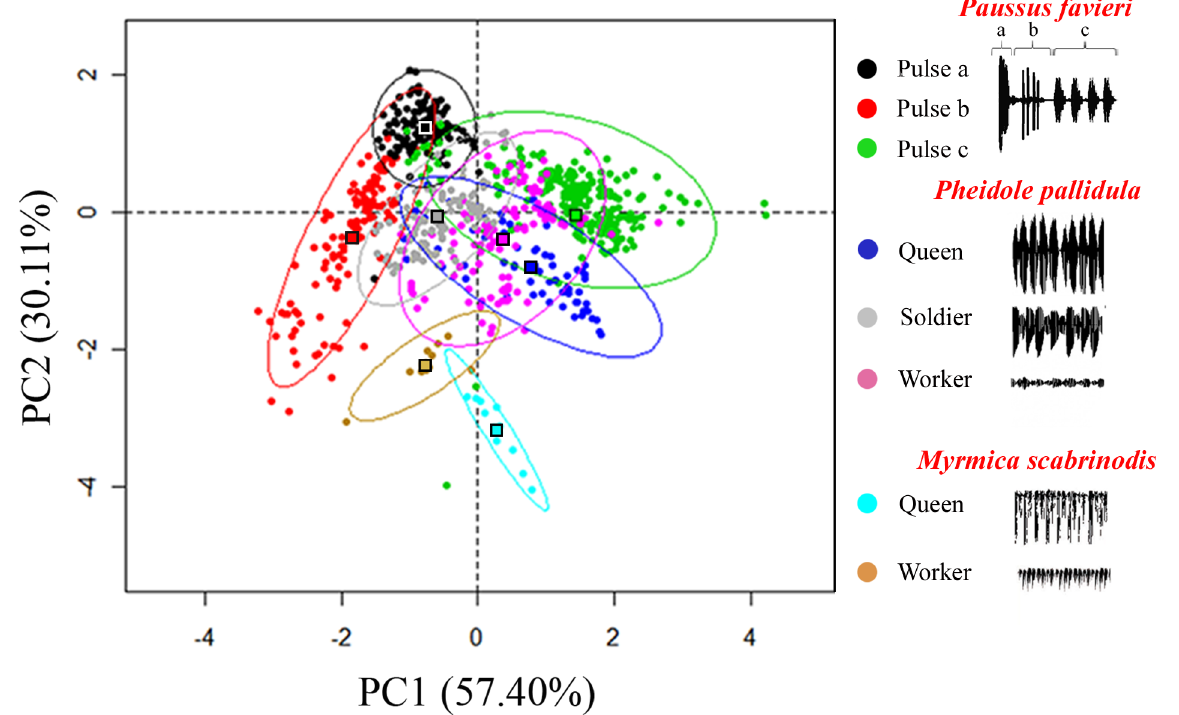
Fig 3. Principal Components Analysis (PCA) of acoustic parameters. Combined effects of the three sound parameters (pulse length, frequency, and intensity) shown as the first and second component plot of a principal components analysis over all individual pulse measurements; ovals indicate 95% confidence intervals; filled squares indicate the centroid for each group. Sounds produced by Myrmica queen and worker ants are also plotted for comparison. The first component explained 57% of total variance and was mainly influenced by pulse length (waveform parameter). The second component accounted for 30% of total variance and significantly discriminated groups on the basis of peak frequency (spectral parameter). Component loadings of PC1: Pulse length: 0.893, Frequency: 0.602; Intensity: -0.749. Component loadings of PC2: Pulse length: -0.042, Frequency: 0.764; Intensity: 0.564. Univariate analysis of variance (ANOVA) performed on PCA factors showed significant difference among groups (see